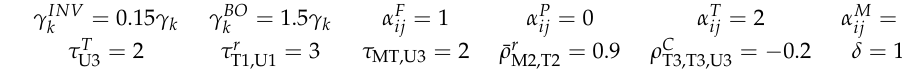
Table 1. Parameter values for the case study.